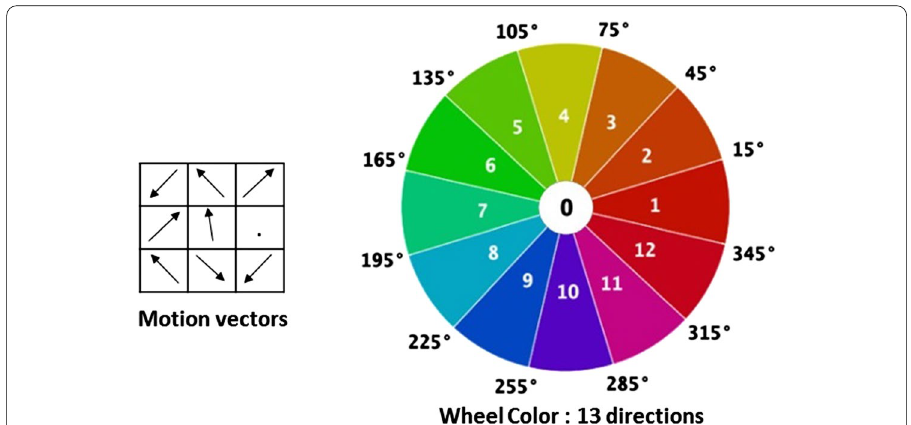
Fig. 6 Classification of motion vector